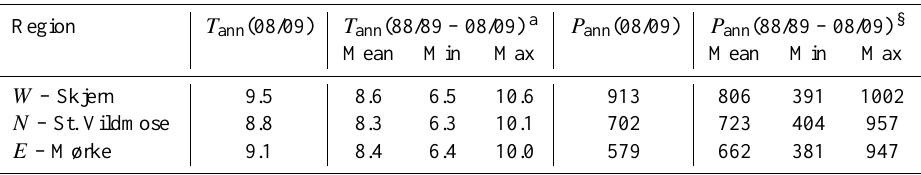
Table 1. Average annual mean temperature, T ann (08/09), and precipitation, P ann (08/09), were calculated for each region for the period 21 September 2008 to 20 September 2009, the period that was used for estimating annual fluxes of CH 4 and N 2 O. The table also shows 20-yr means and range of annual temperature and precipitation in each